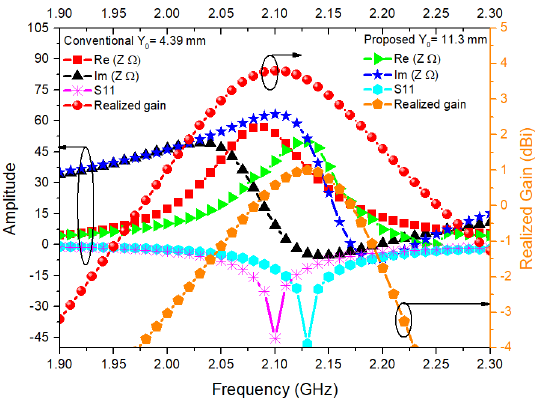
Figure 3. Impedance, reflection, and gain of the conventional and the proposed antenna.